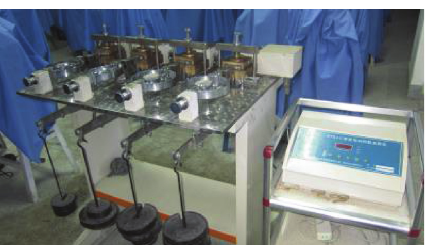
Figure 4: STSJ-5 smart electric quadruple direct shear